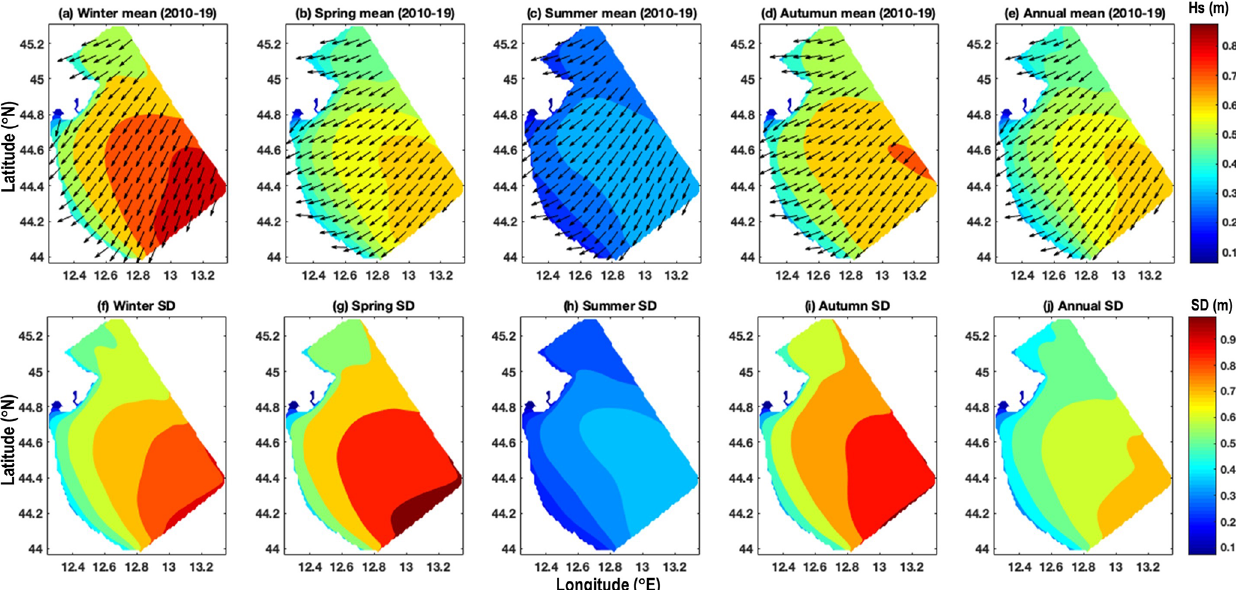
Figure 5. Wind rose diagrams at the control points shown in Fig. 1 based on monthly average winds throughout 2010–2019. The wind rose shows the direction the winds come from (N: north; NE: northeast; E: east; SE: southeast; S: south; SW: southwest; W: west; NW: northwest).